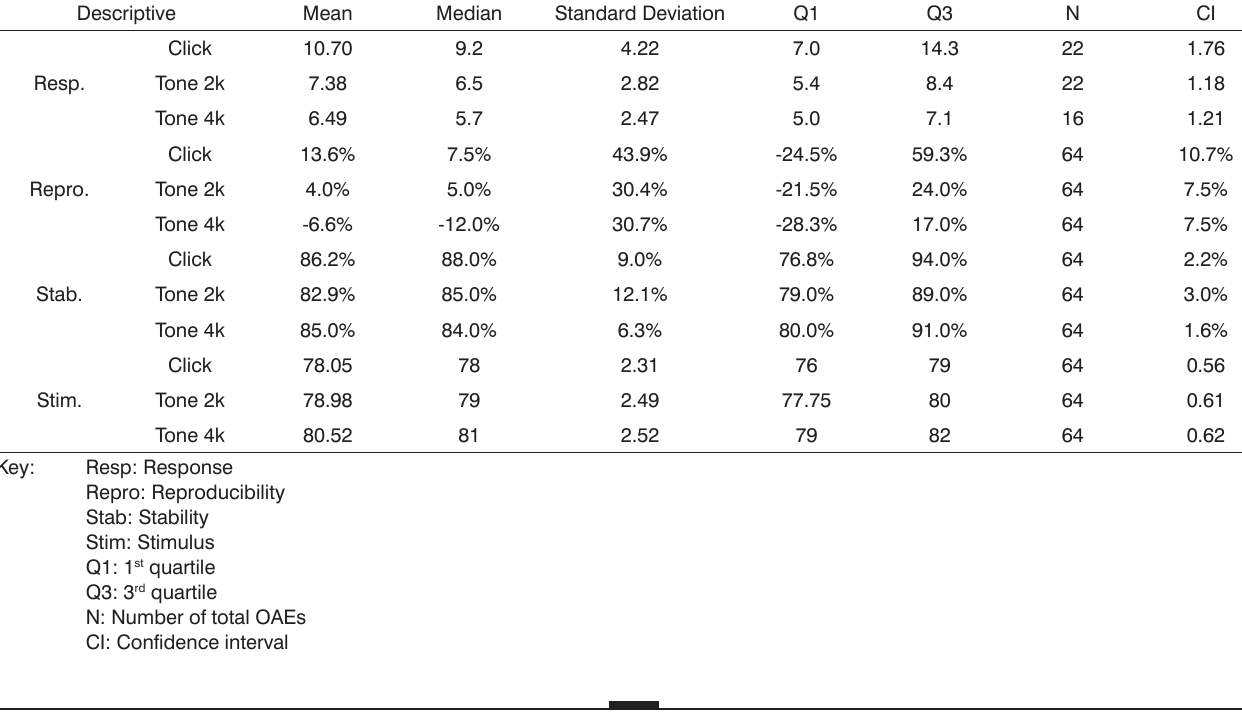
Table 1. Descriptive measures for the parameters response, reproducibility, stability, and OAEs with clicks and tone pips at 2,000 Hz and 4,000 Hz, for both ears and different levels of hearing loss.